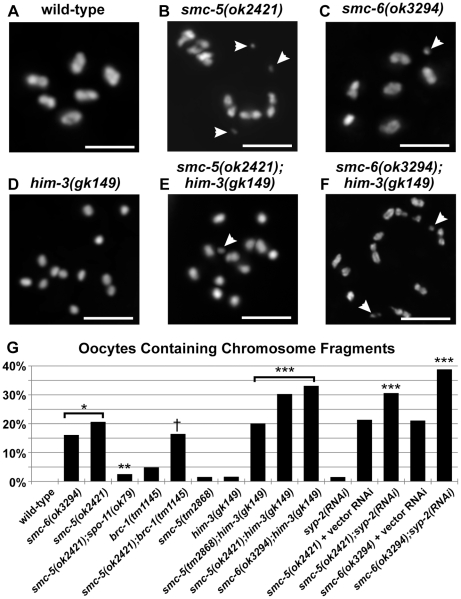
Chromosome fragmentation defects linked to homolog-independent repair of meiotic DSB.(A–F) Micrographs of DAPI-stained diakinesis chromosomes are shown at the same magnification. Chromosomal fragments are indicated by white arrowheads, and scale bars = 5 µm. (G) A graph of the percentages of diakinesis oocytes containing chromosome fragments. The smc-5(ok2421) and the smc-6(ok3294) mutant oocytes showed significantly higher frequency of chromosome fragmentation over wild-type (*p<0.001, Fisher's Exact Test). The smc-5(ok2421) fragmentation defect was drastically suppressed by the spo-11(ok79) mutation (**p = 0.006). The disruption of inter-homolog recombination by destabilizing homolog-synapsis consistently enhanced the fragmentation defects in all three smc-5 and smc-6 mutant strains (***). By contrast, the brc-1 mutation affecting sister-chromatid recombination [7] failed to enhance the fragmentation defect of the smc-5(ok2421) mutation (†). The numerical values, sample sizes, and statistical comparisons are summarized in Table S5.